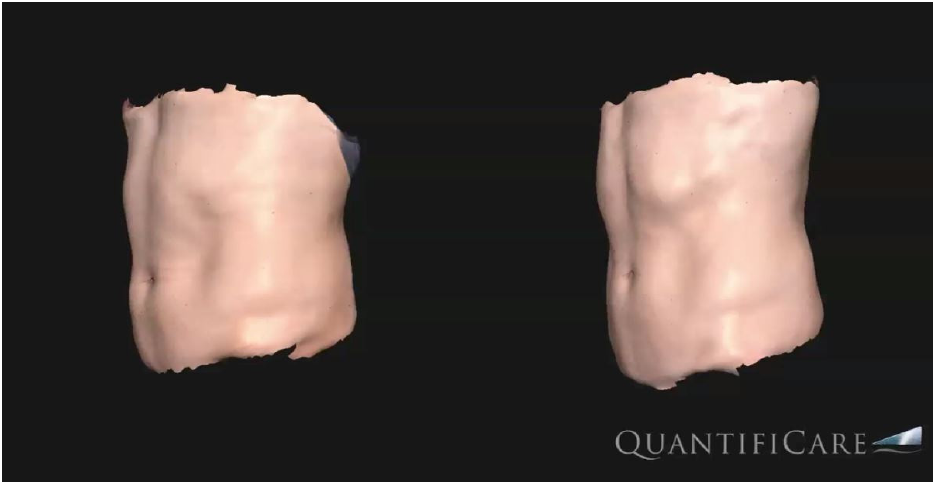
Figure 3. Three-dimensional (3D-Quantificare) optical abdominal skin surface image of a male patient before ( left ) and three months after the last treatment ( right ).